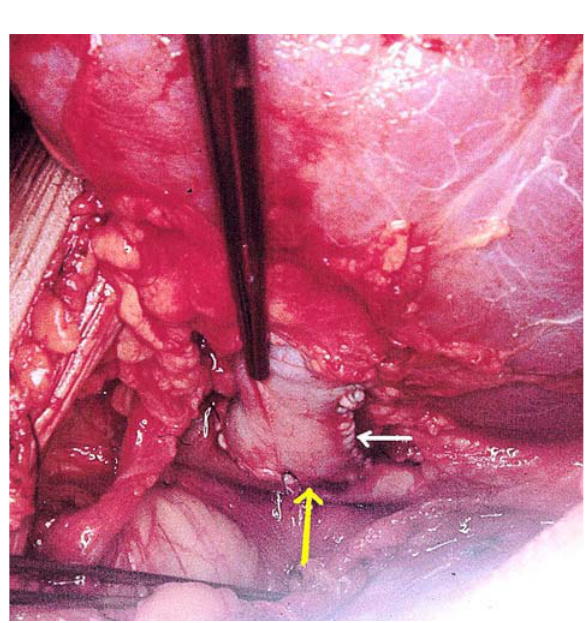
Figure 5 – Intraoperative picture of the right renal vein elon- gated (white arrow) and anastomosed end-to-side to the exter- nal iliac vein (yellow